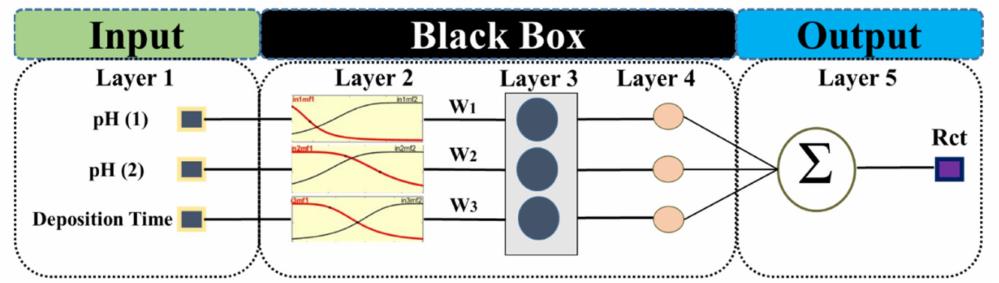
Figure 2. Typical structure of the ANFIS model for modeling the corrosion behavior of CeCCs; the model comprises 3 inputs and 5